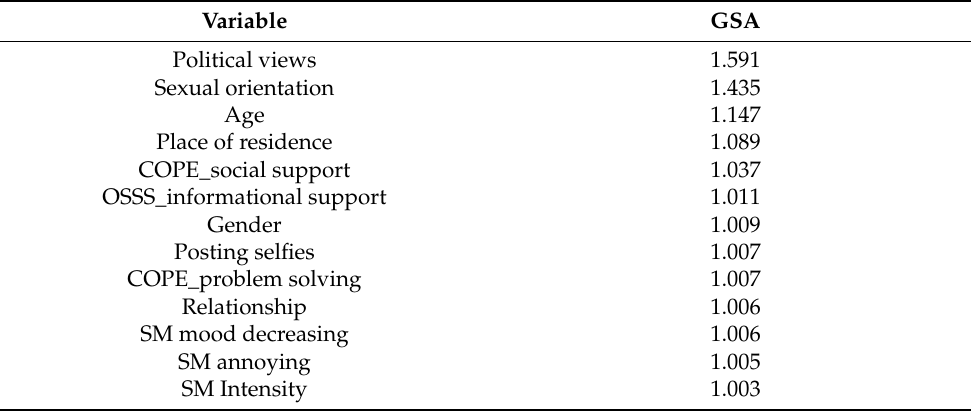
Table 3. ANNs global sensitivity analysis